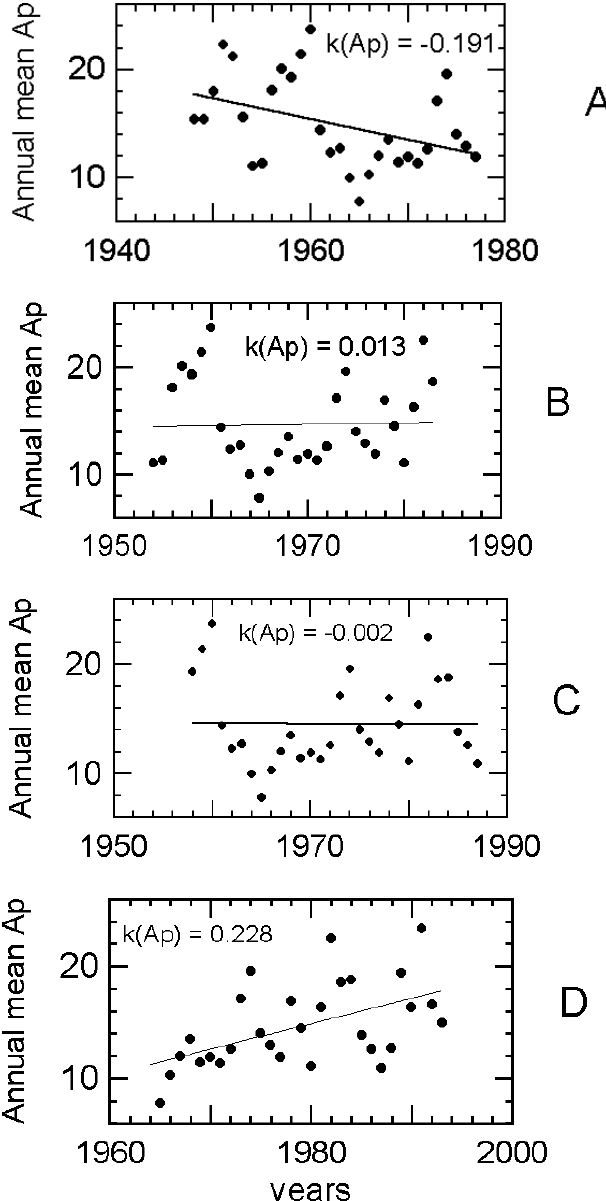
Fig. 1. Variation of the annual mean value of A p during: (a) the first 30-year interval 1948–1977, two intervals in the middle of the period considered (b) 1954–1977 and (c) 1958–1987, and (d) the last interval